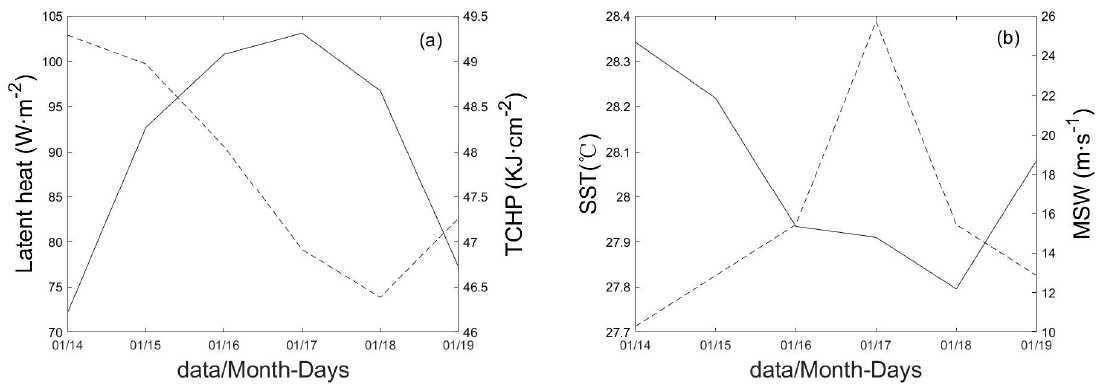
Figure 5. ( a ) Time series of mean latent heat fluxes and TCHP in anticyclonic eddy W1 from 14 to 19 January. Solid lines represent latent heat fluxes, and dashed lines represent TCHP. ( b ) Time series of mean SST and TS maximum wind speed of the anticyclonic eddy W1 during 14–19 January. The solid line indicates the SST, and the dotted line indicates the maximum wind speed of TS.